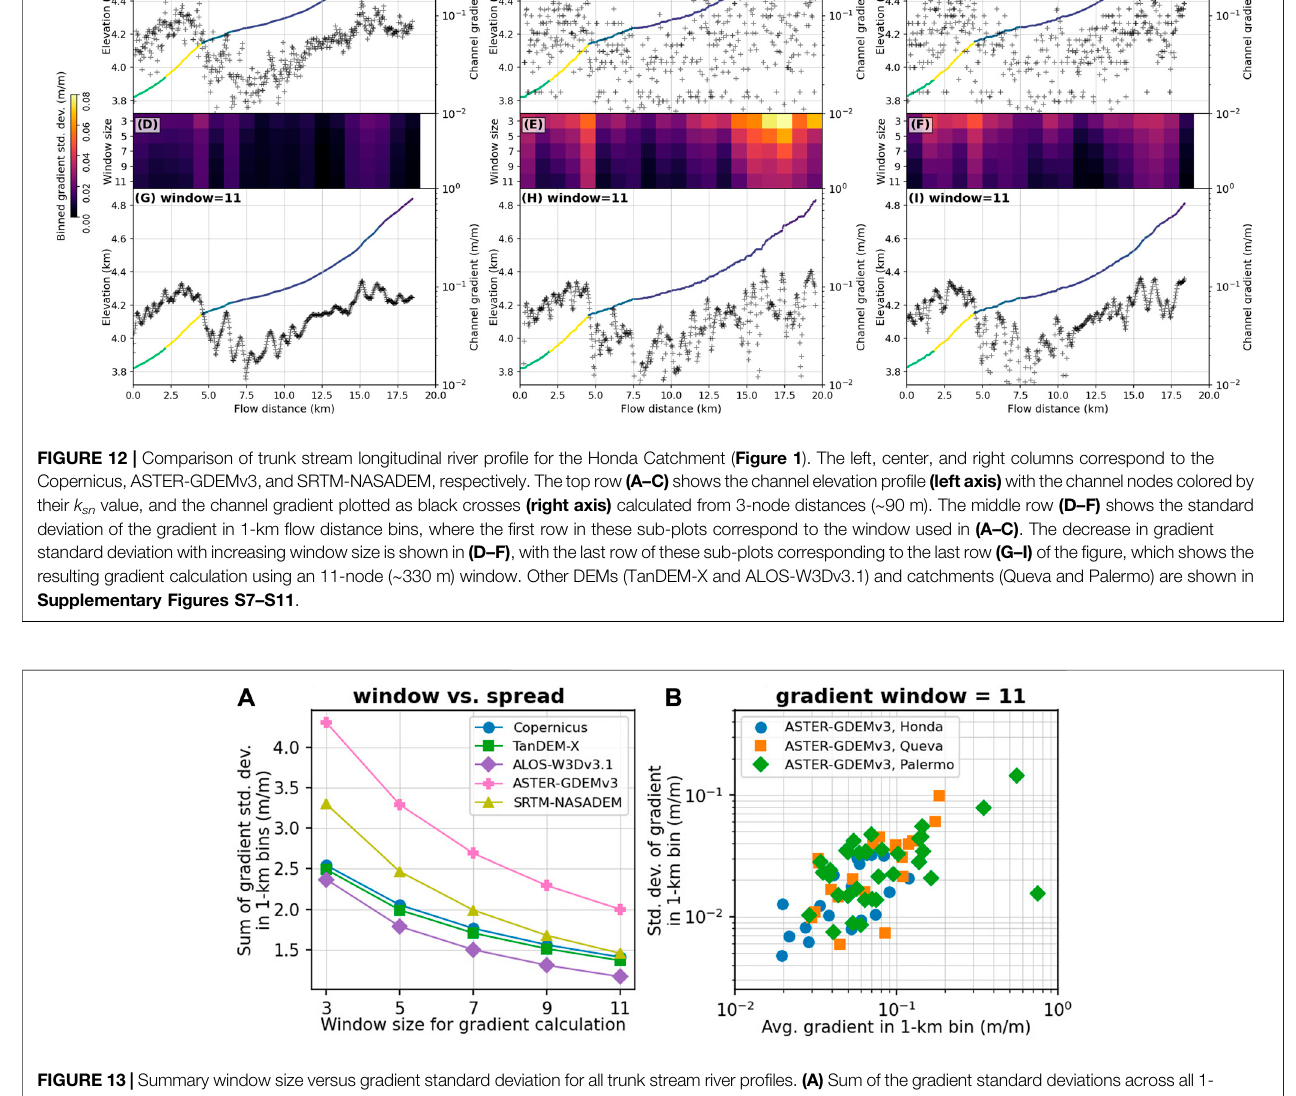
FIGURE 13 | Summary window size versus gradient standard deviation for all trunk stream river pro fi les. (A) Sum of the gradient standard deviations across all 1- km fl ow distance bins in each catchment for each DEM. Note that the DEM with the lowest inter-pixel consistency (ASTER-GDEMv3, pink) shows the strongest smoothing effect with increasing window size. But even with an 11-node window smoothing, the standard deviation is 30 – 50% higher than for the other DEMs. Smoothing of the SRTM-NASADEM (yellow) leads to near convergence of standard deviations with the Copernicus DEM. The ALOS-W3Dv3.1 (purple) is overall smoother, potentially duetoahydrologicpreconditioning step. (B) Relationshipbetween standarddeviationofgradient and averagechannelgradient ineach 1-km fl ow distance bin for all three catchments for ASTER-GDEMv3, with gradient calculated in an 11-node window. Higher gradients have higher standard deviation, suggesting that higher gradients have lower inter-pixel